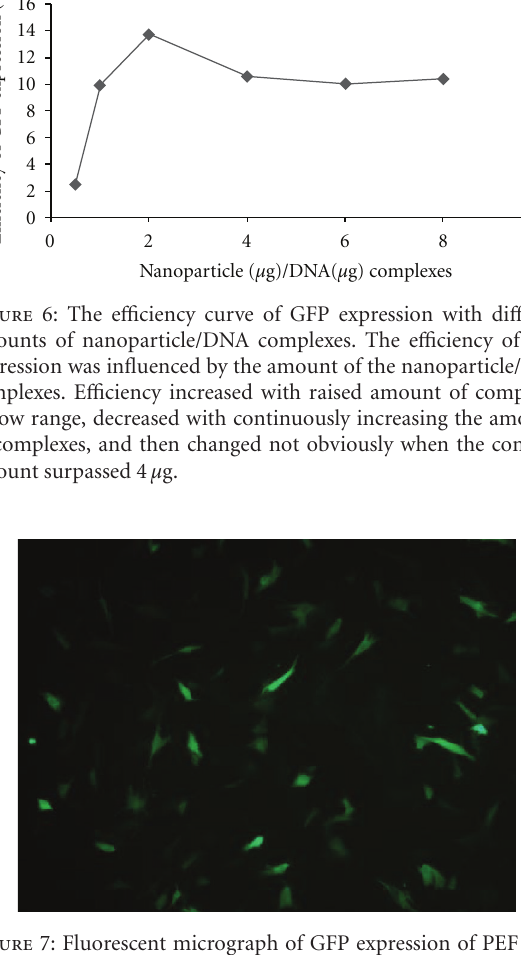
Figure 7: Fluorescent micrograph of GFP expression of PEF cells. The gene delivery into PEF cells was also carried out with PEI- modified magnetic nanoparticles but still at a low level of e ffi ciency compared with PK-15